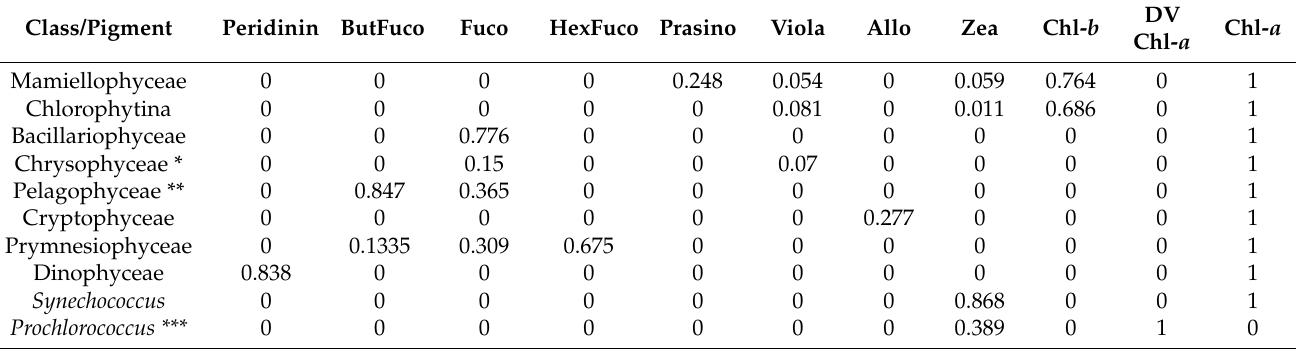
Table 2. Initial ratio matrix which was built based on previous work. The matrix was made by reconstructing the pigment ratio statistics data from Roy et al. [27] to best fit the present study. The Chrysophyceae * was included in June 2019 and August 2018 (Surface) clusters, Pelagophyceae ** was included in October 2019 cluster, and Prochlorococcus *** was Included in August 2018 (Surface), August 2018 (SCM), and October 2019. Other taxa are included in all